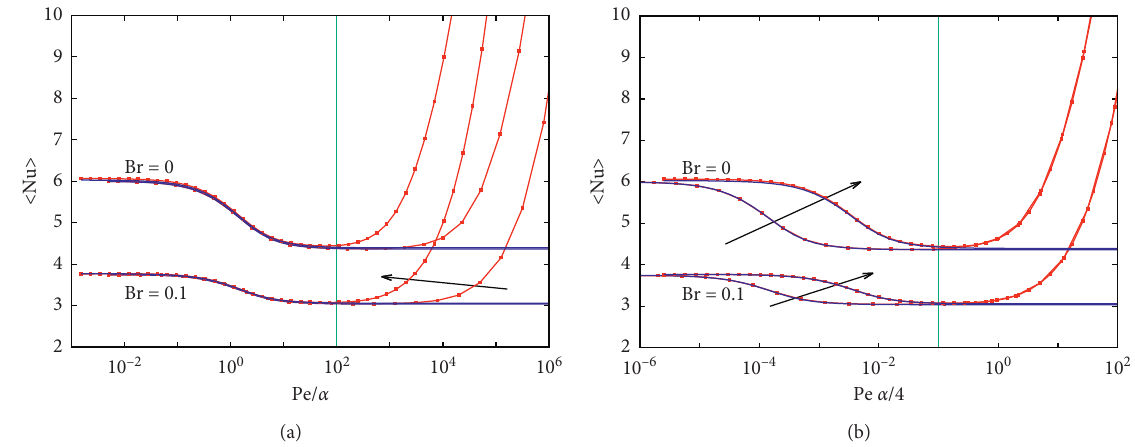
Figure 8: Comparison between numerical (red dotted lines) and analytical results (blue continuous lines) for the average Nusselt 〈 Nu 〉 as a function of Pe/ α (a) and Pe α /4 (b) for q w ( ζ ) � 1. Two different values of α are considered, α � 0 . 02 and α � 0 . 1. Figures 8(a)-8(b) refer to Br � 0 and Br � 0 . 1, Kn � 0. Reference values (vertical lines) are Pe / α � 10 2 and Pe α /4 � 10 − 1 . The arrows indicate increasing values of α .